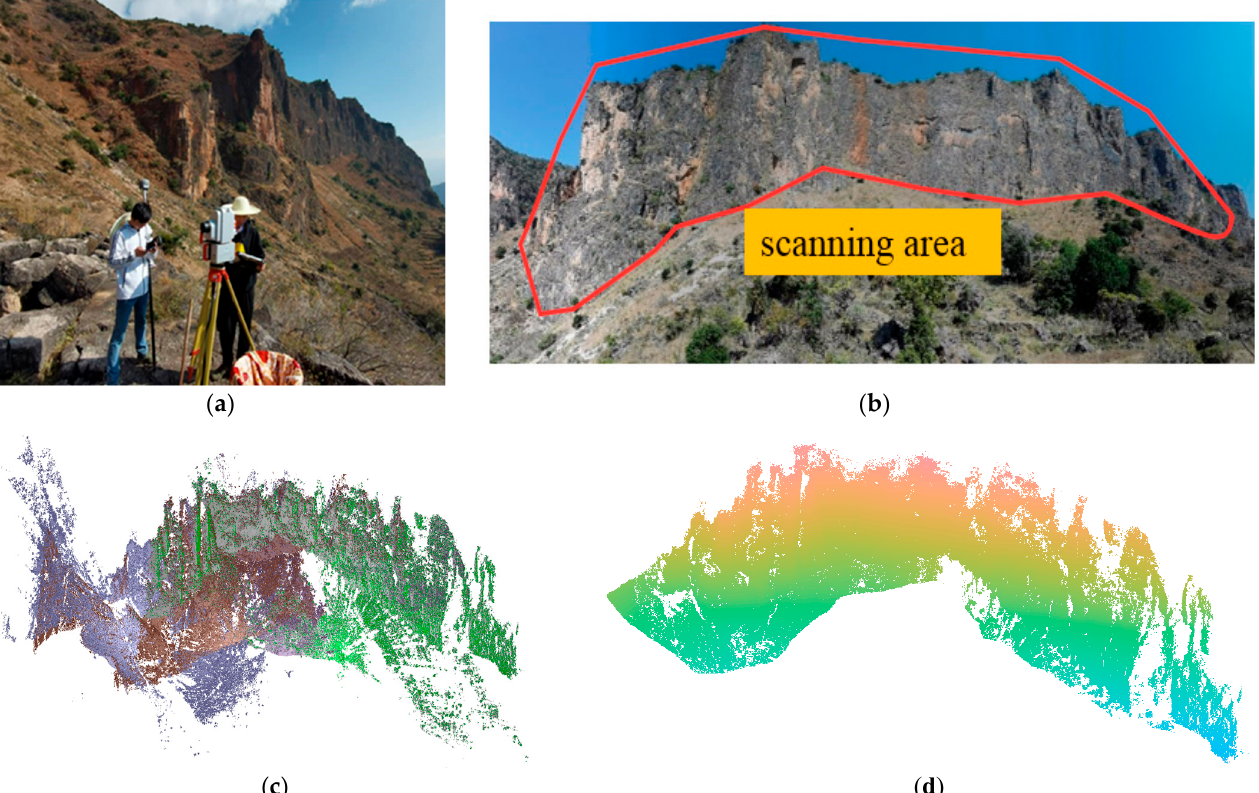
Figure 4. 3D laser data acquisition: ( a ) acquisition of data by ground-based 3D laser scanner; ( b ) scanning area field map; ( c ) scanning point cloud alignment map; ( d ) preprocessing result of point cloud in scanning area.